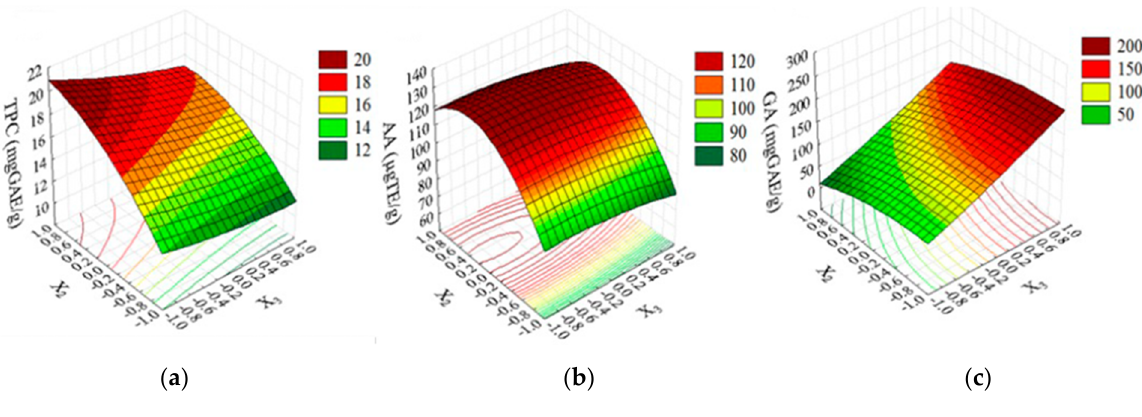
Figure 3. Response surface for the TPC ( a ), AA ( b ), and GA ( c ) at X1= − 1.